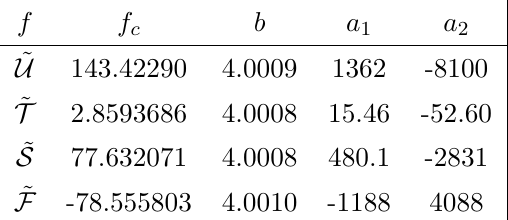
Q b ( a 1 + a 2 log Q ) where f stands for di(cid:11)erent (cid:0)